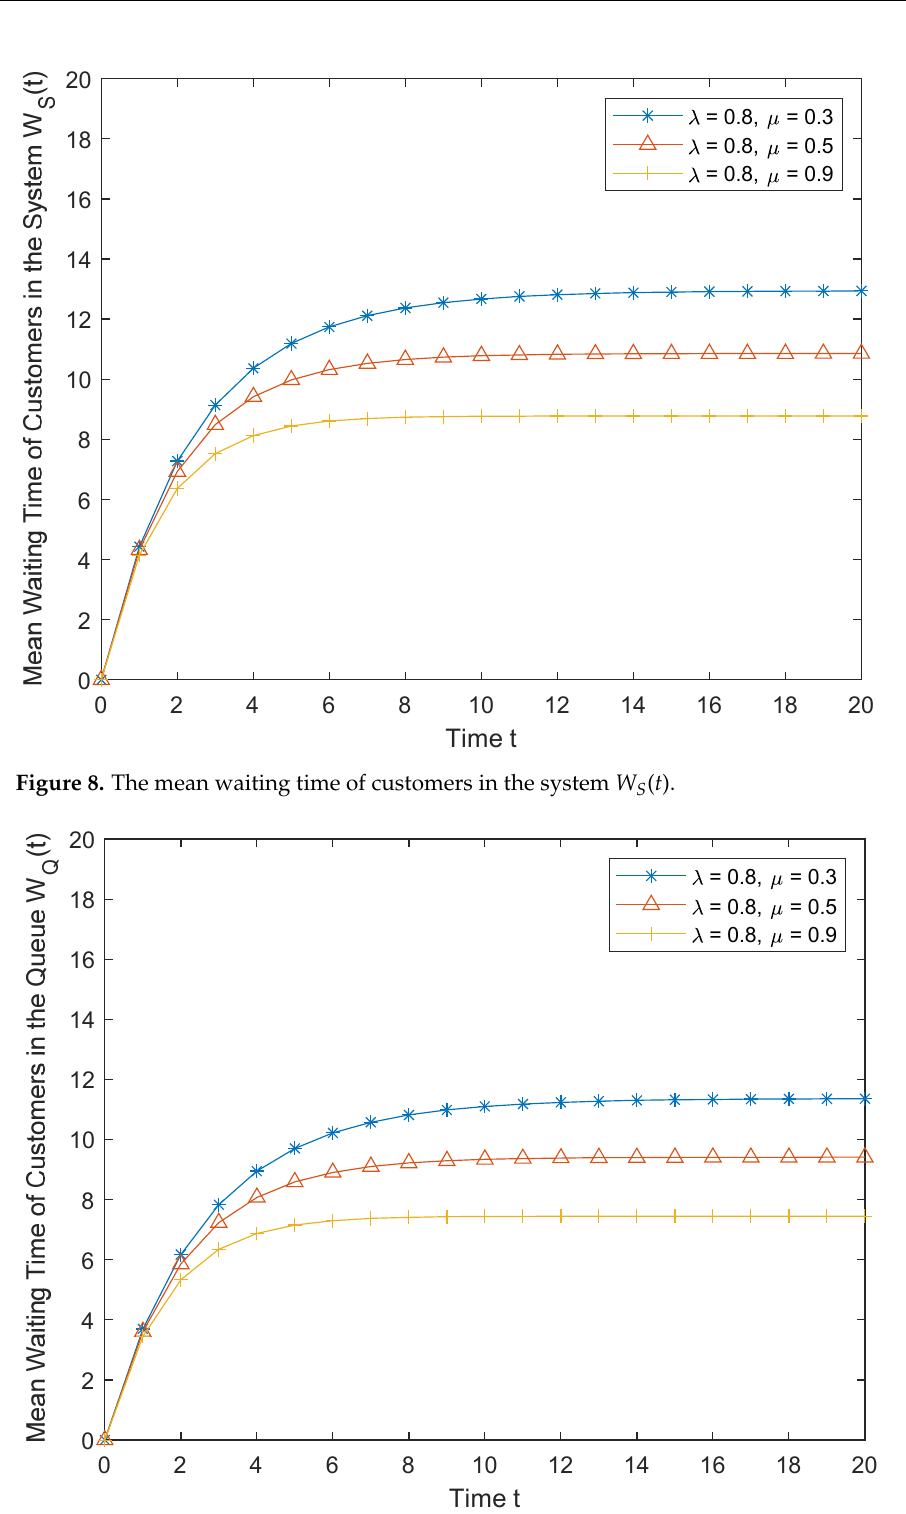
Figure 9. The mean waiting time of customers in the queue W Q ( t ).